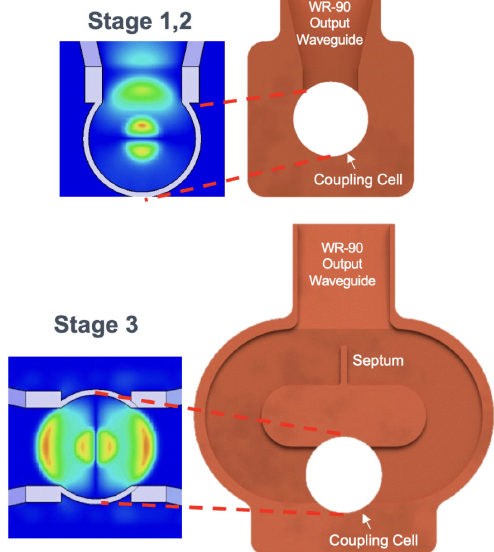
FIG. 5. The asymmetric coupler in the Stage I/II experiments (top right) generated a vertically-asymmetric mode in the coupling cell (top left). The symmetric coupler implemented in the Stage III experiment (bottom right) eliminated this asymmetric mode (bottom left) and the associated transverse kick. The field plots show the normalized magnitude of E E , respectively. x